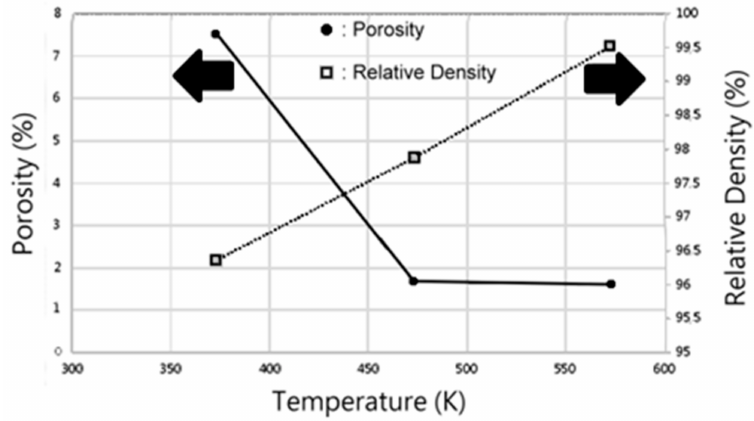
Figure 6. Density and porosity of vacuum hot pressed samples prepared with different temperatures. Pressure: 0.98 GPa, time: 30 min.